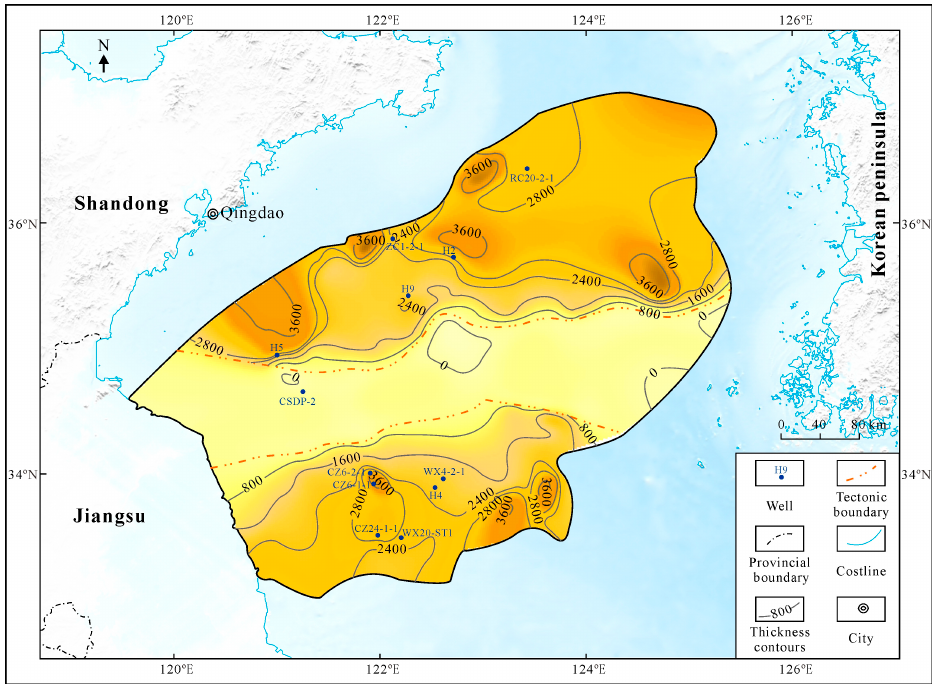
Figure 6. Map of Cenozoic strata thickness in the South Yellow Sea Basin.